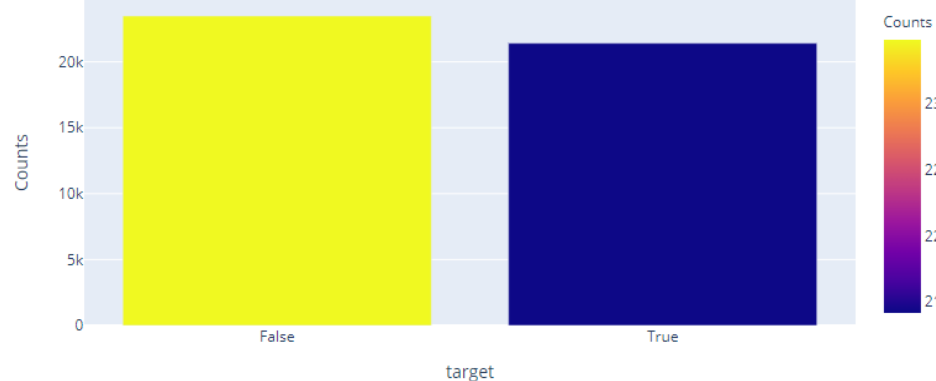
Figure 1. The number of fake and real news articles.